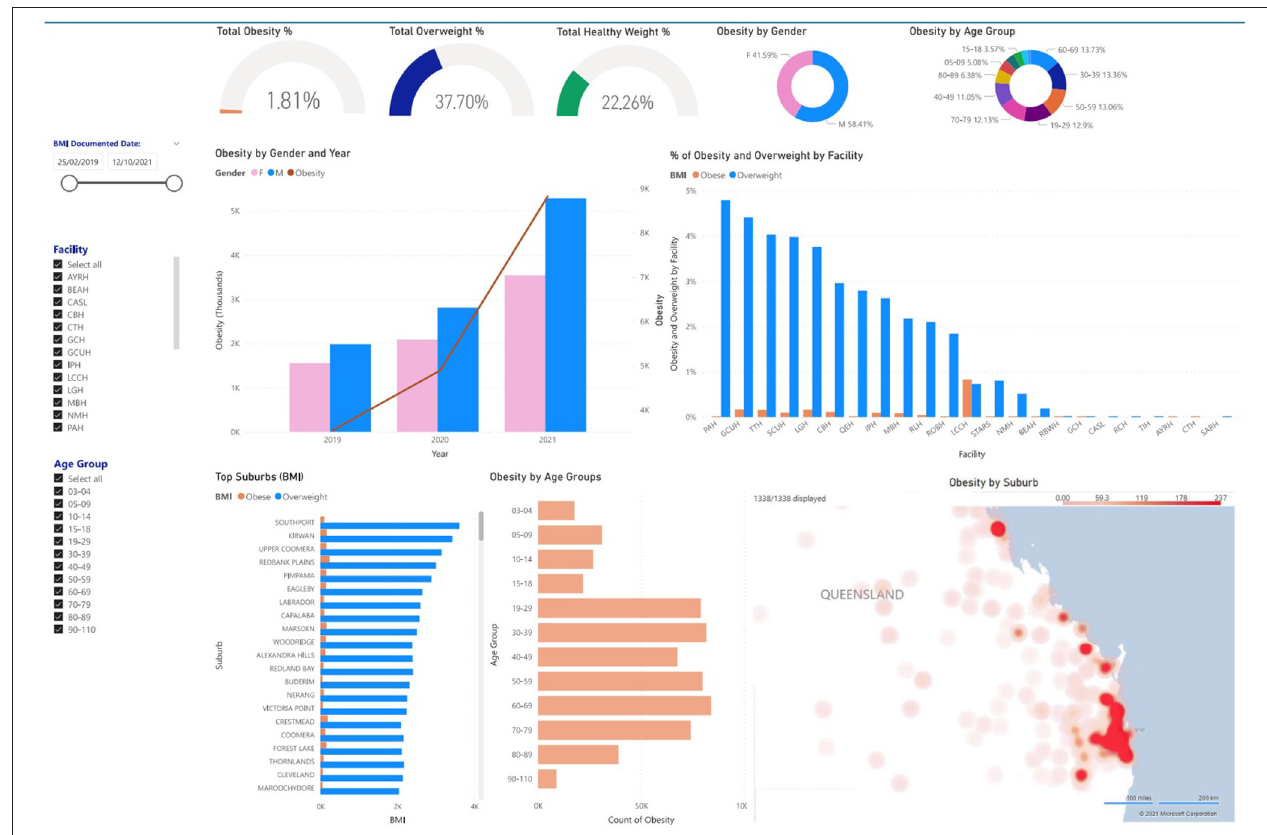
FIGURE 3 | Population Health Queensland (PopHQ) proof-of-concept